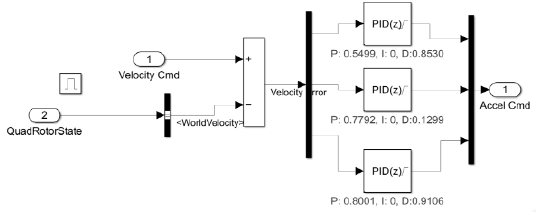
Figure 8. Velocity control design